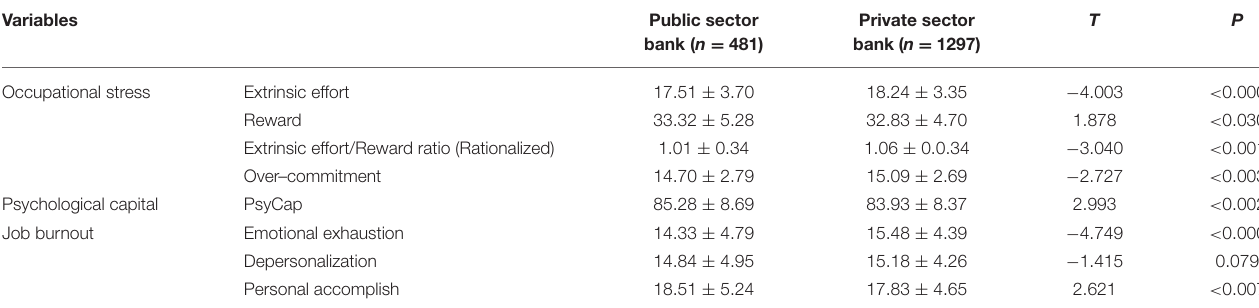
TABLE 6 | Comparison of occupational stress, psychological capital, and job burnout between public and private banking sector employees.